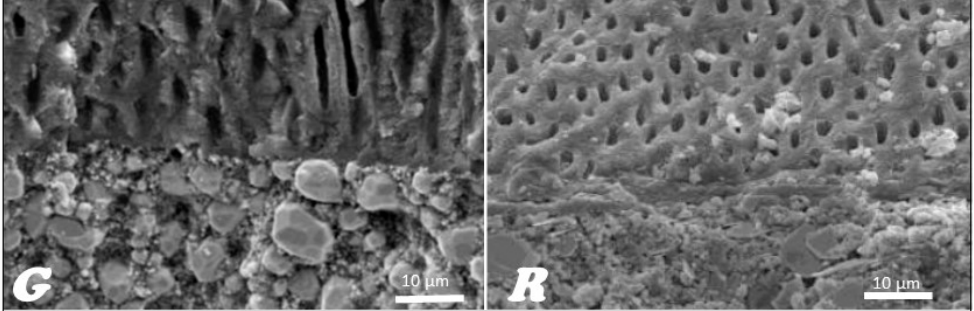
Figure 20. Connection of the dentin of the root canal with the visible dentin tubules after cold lateral condensation after filling the root canal with a material based on gutta ‐ percha ( G ) and resilon ( R ) covered with sealant; SEM. Hot root canal obturation by thermoplastic condensation using the Thermo ‐ Hydrau ‐